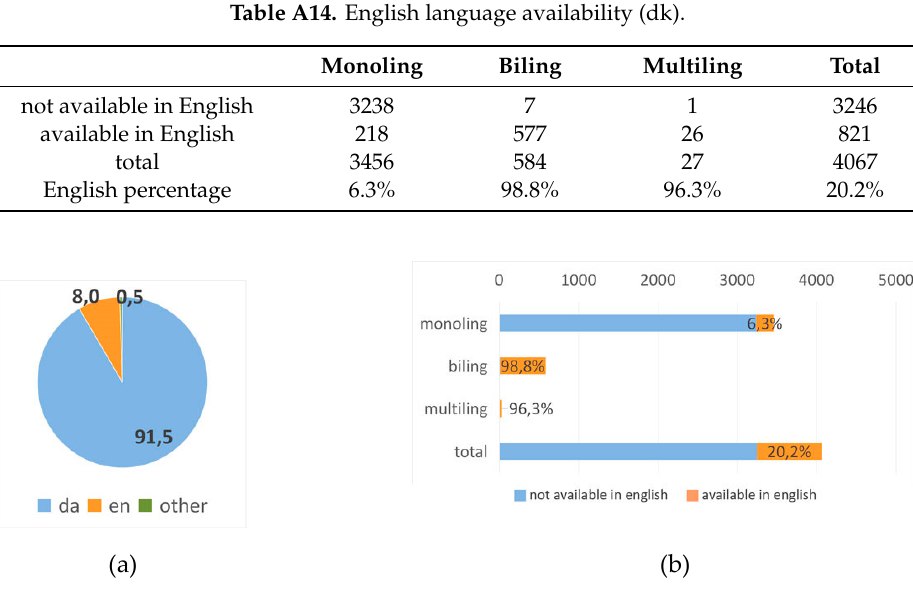
language availability bar chart.